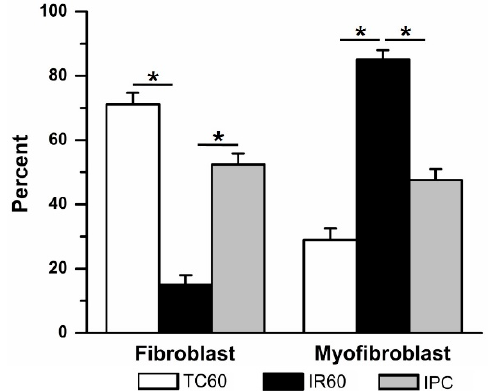
Figure 5. Ischemic preconditioning (IPC) prevented ischemia reperfusion (IR, 60 min)–induced fibroblast to myofibroblast differentiation. When compared to time control (TC), 60 min IR caused significant fibroblast to myofibroblast differentiation (data repeated from Figure 4). In contrast, adding a single episode of brief (15 min) ischemia and 30 min reperfusion prior to 60 min IR (IPC) significantly prevented fibroblast differentiation. * p < 0.05, comparisons indicated by the lines.